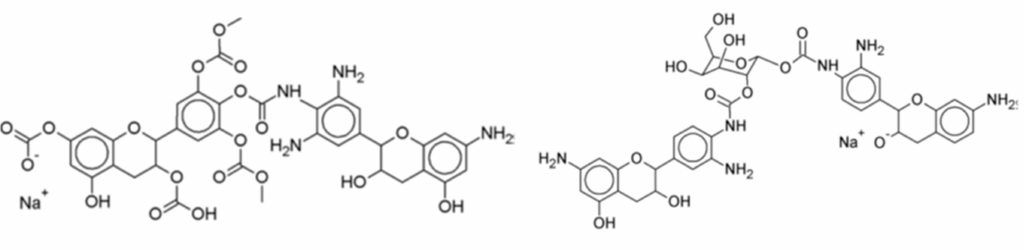
Figure 12. Examples of compounds presenting urethane linkages formed by the reaction of a pre-aminated flavonoid tannin with a flavonoid tannin pre-reacted with dimethyl carbonate.